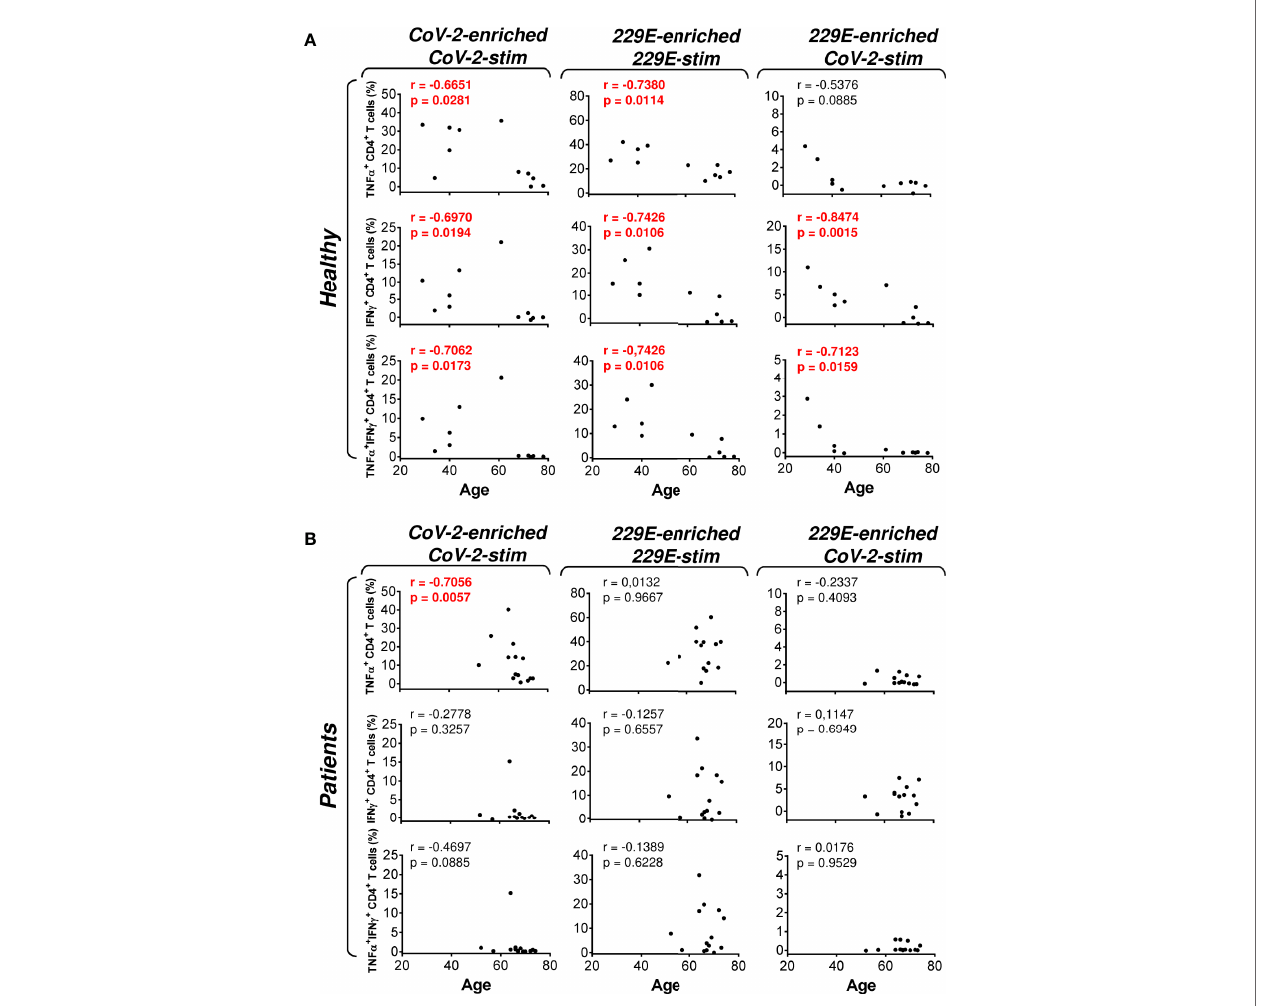
FIGURE 6 | Association of the healthy male volunteer ’ s and HR metastatic PCa patient ’ s age with the SARS-CoV-2/HCoV-229E peptide pool reactivity or SARS-CoV-2 peptide pool cross-reactivity of CD4 + T cells in the peptide-enriched cell cultures (A, B) Cell cultures of 11 healthy male volunteers (Healthy) (A) and 14 HR metastatic PCa patients (Patients) (B) were SARS-CoV-2-enriched/SARS-CoV-2-stimulated (CoV-2-enriched/CoV-2-stim), HCoV-229E-enriched/HCoV-229E-stimulated (229E-enriched/229E- stim), or HCoV-229E-enriched/SARS-CoV-2-stimulated (229E-enriched/CoV-2-stim) and the correlations of the subject ’ s age with the proportions of TNF a -, IFN g -, or TNF a / IFN g -producing CD4 + T cells determined. In (A, B) , the correlations were evaluated by Spearman ’ s rank-order correlation coef fi cient (r) and the signi fi cance ( P value) determined ( n = 11 healthy male volunteers, n = 14 HR metastatic PCa patients). In (A, B) , P > 0.05 were considered nonsigni fi